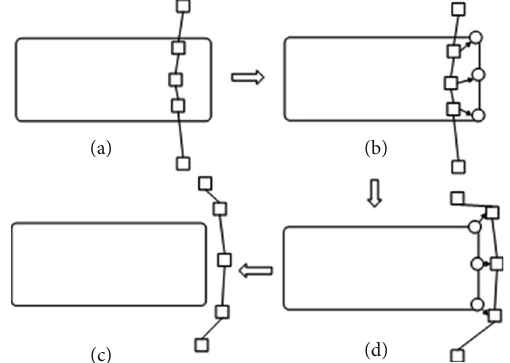
Figure 11: Adjustment of the bounding shell. (a) Intersections with the cage and an obstacle; (b) map the inside vertexes to the edge of the obstacle; (c) remove the inside points out of the obstacle depending on the mapping direction; (d) result of mesh deformation.